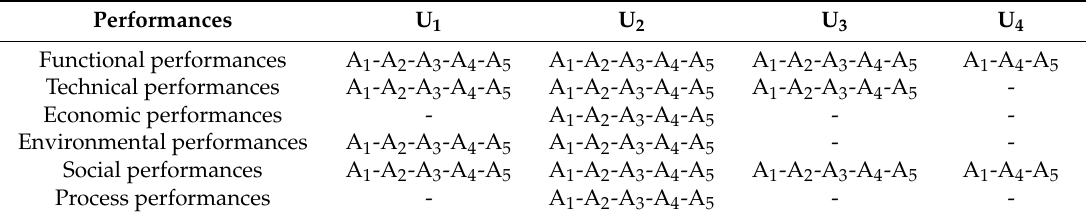
Table 1. Final assessment per typology of user in relation to each functional area.